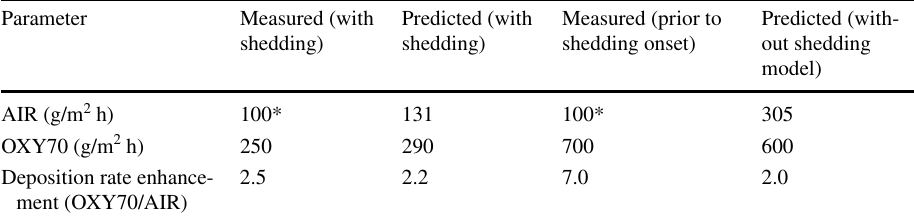
Table 7 Deposition rate prediction (g/m 2 h) with and without shedding